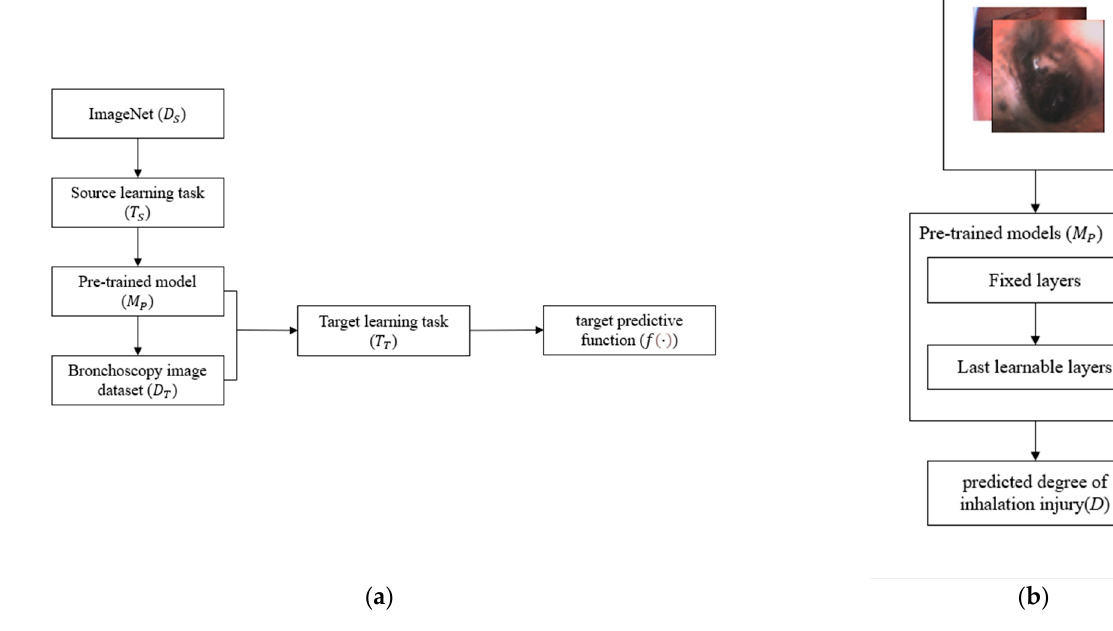
Figure 6. ( a ) The flow chart of training transfer measure the target predictive function f ( · ) from D T in T T . ( b ) The diagram of how the layers in pre-trained models ( M P ) help to predict the degree of inhalation injury ( D ).